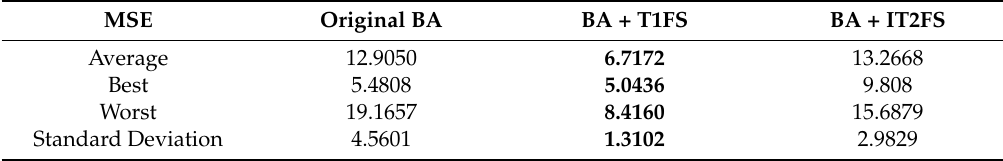
Table 13. Comparison of results of the original BA, the BA + T1FS and BA + IT2FS.